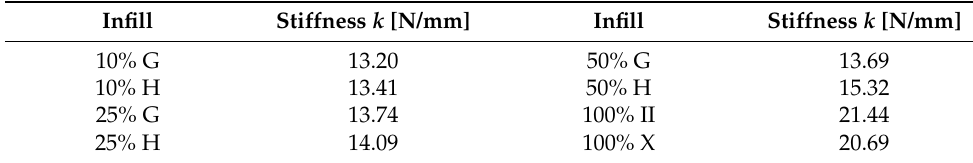
Table 4. Stiffness k values of each series at 20 N. Infill Stiffness k [N/mm]